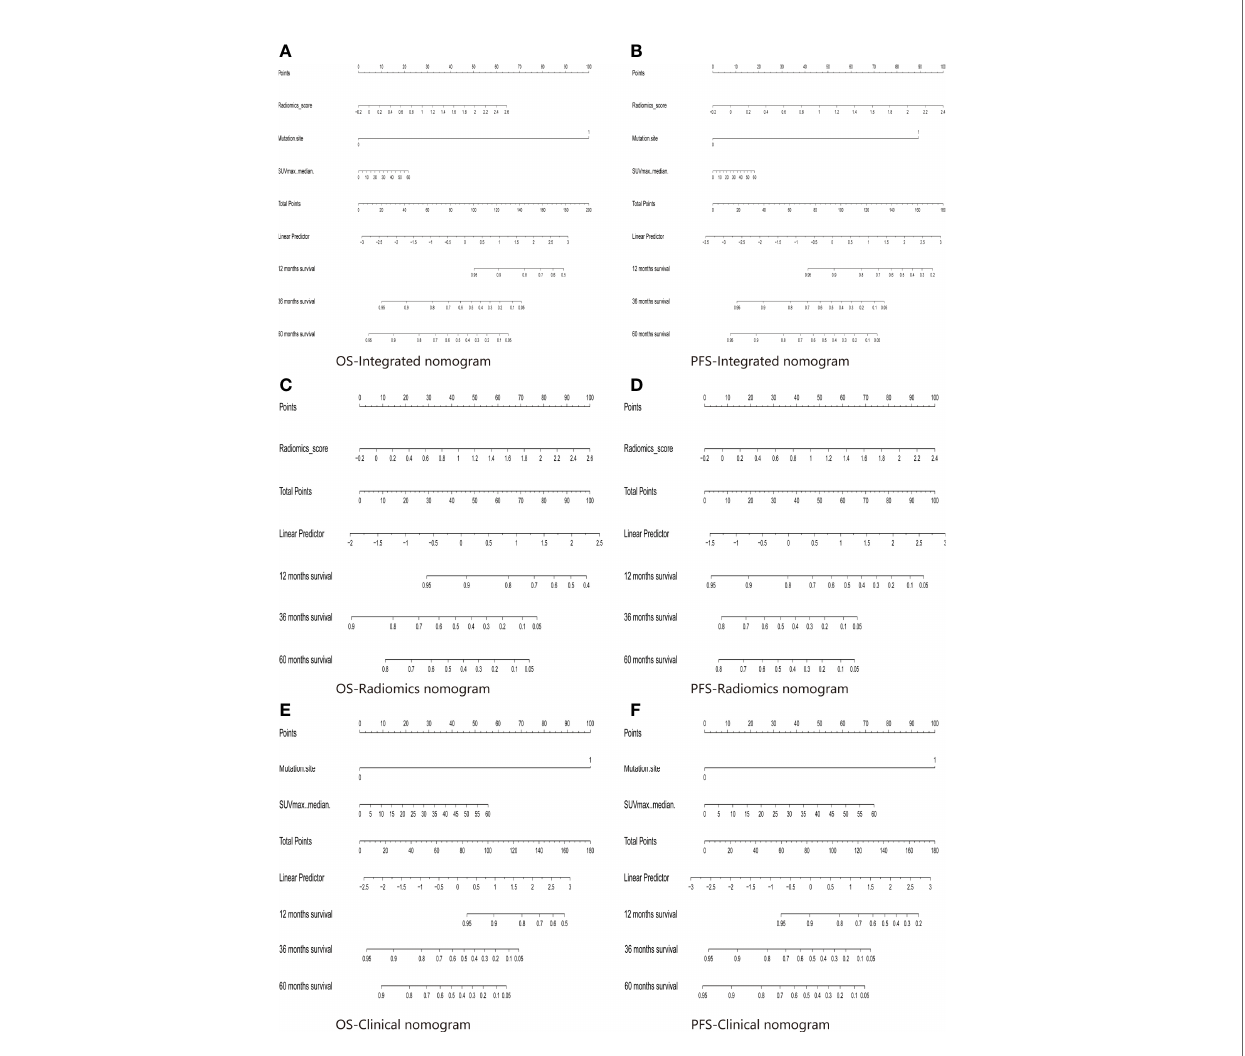
FIGURE 4 | The Integrated model for OS (A) and PFS (B) prediction based on rad-score and clinical factors (mutation site, SUVmax). The Radiomics model for OS (C) and PFS (D) prediction based on rad-score. The Clinical model for OS (E) and PFS (F) prediction based on clinical factors (mutation site, SUVmax).